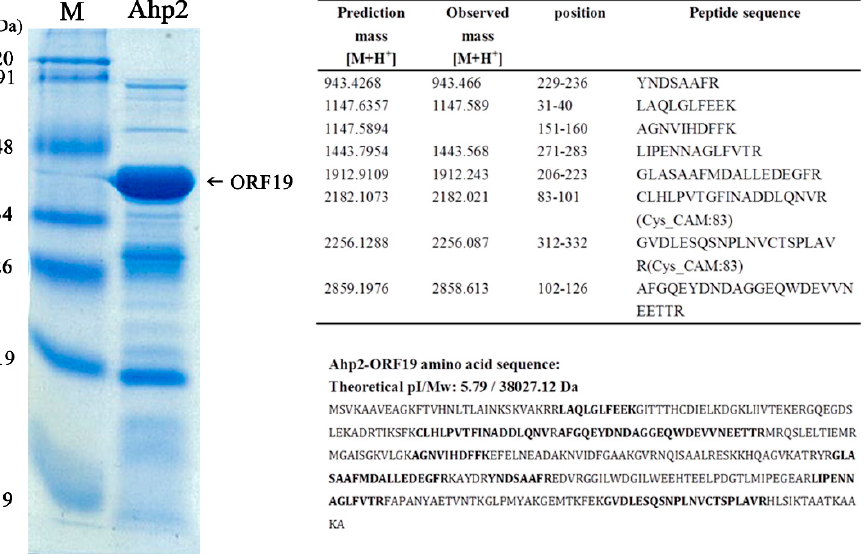
Figure 5. Ahp2 virion proteins. Phage particles (5 × 1011 PFU) were boiled in sample buffer (20 μ L) and subjected to SDS-polyacrylamide gel electrophoresis (8–16% gradient). The arrow indi- cates ORF19, which has been identified by peptide mass fingerprinting as the major coat protein of Ahp2. The peptide fingerprints matched the deduced sequence of ORF19 shown in the right panel. Cysteine residues in the protein were converted to carbamidomethyl-cysteine (Cys_CAM) with iodoacetamide. Lane M, pre-stained middle range protein marker. Boldfaced sequence: peptide identified by MALDI-TOF.